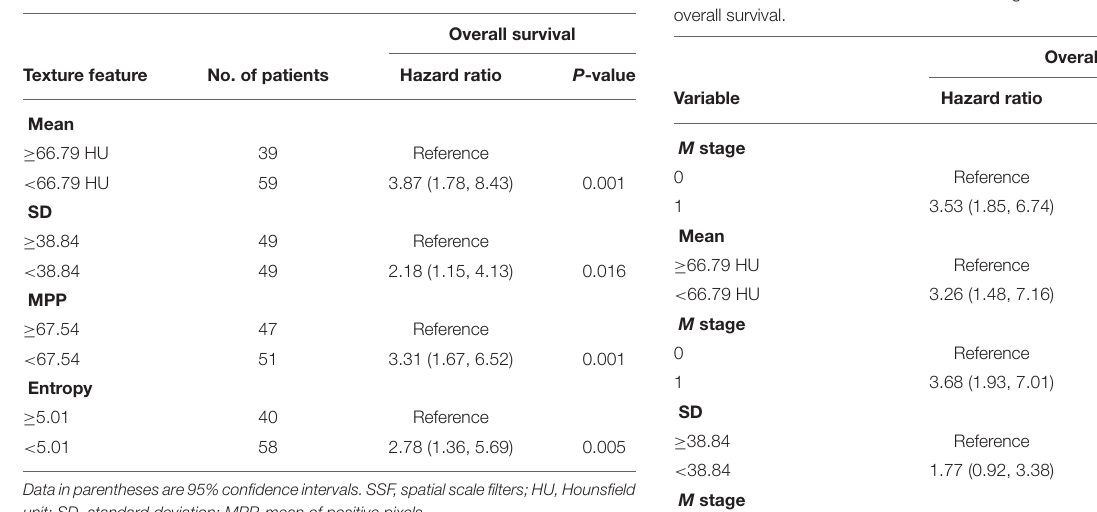
TABLE 3 | Univariate Cox proportional hazard analysis of CT texture features associated with worse overall survival.